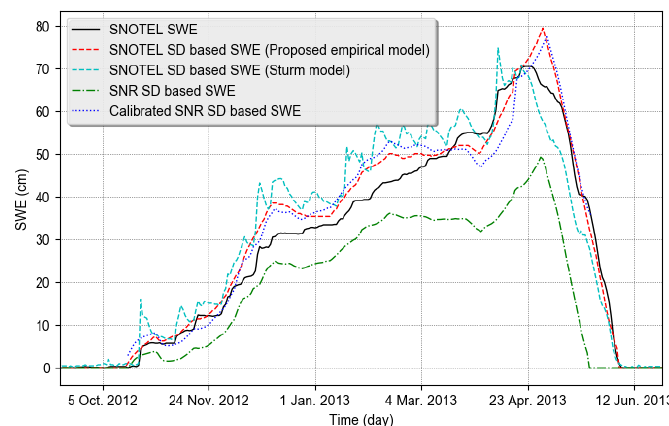
Figure 12. Comparison of SNOTEL SWE, SNOTEL SD-based SWE and SNR SD-based SWE estimations in a snow season.